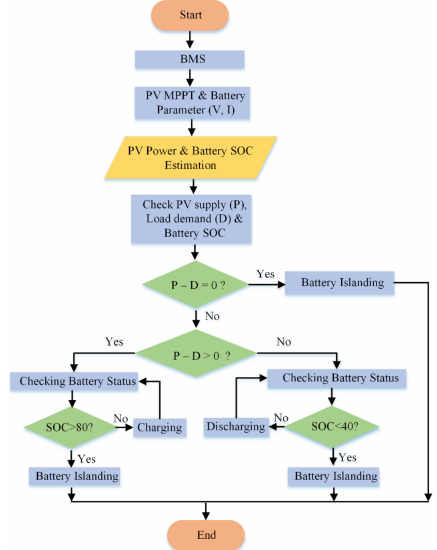
Figure 5. Flowchart for the entire